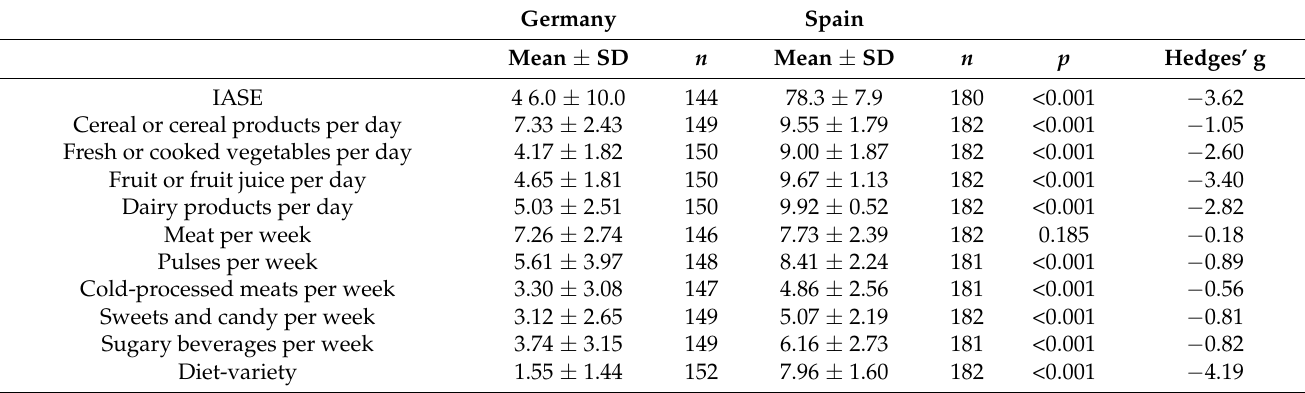
Table 4. IASE and its variables by country.